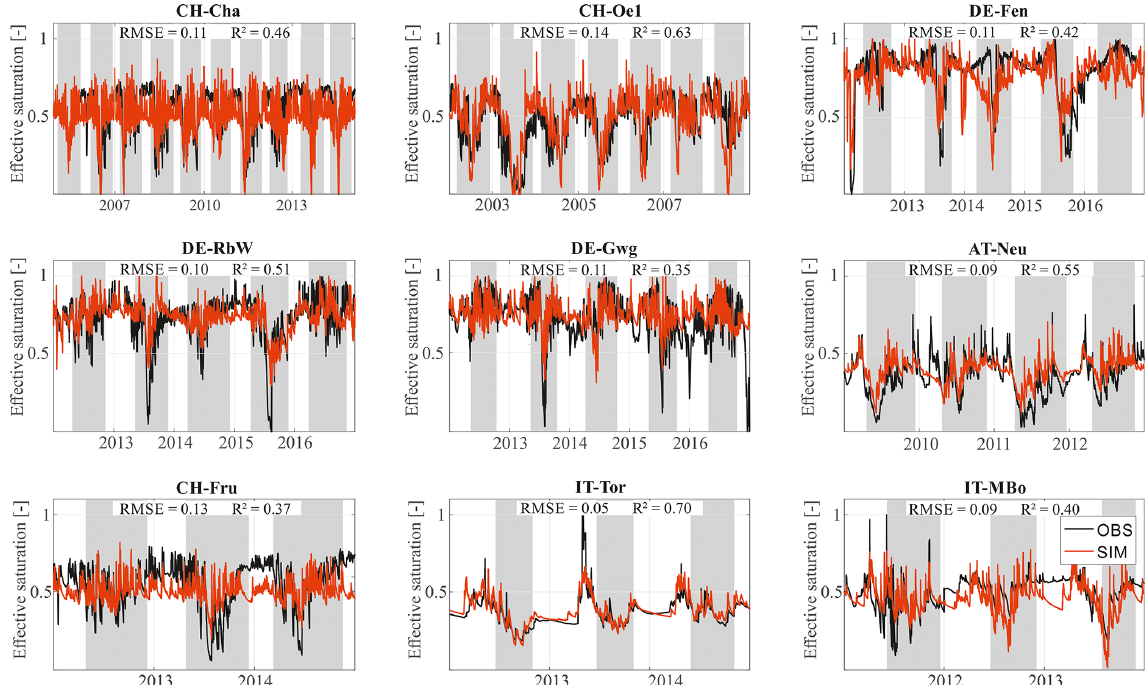
Figure 3. Observed vs. simulated daily effective saturation. We compare the observed (black) and measured (red) pattern of the effective saturation across all the sites. In CH-Cha, AT-Neu, CH-Fru, and IT-Tor soil water content is measured at 5cm depth; in CH-Oe1 and IT-MBo it is at 10cm depth; and in DE-Fen, DE-RbW, and DE-Gwg it is at 12cm depth. The goodness of fit metrics room-mean-square error (RMSE) and coefficient of determination ( R 2 ) are reported for each station in each subplot. Gray areas represent the growing seasons for each year and